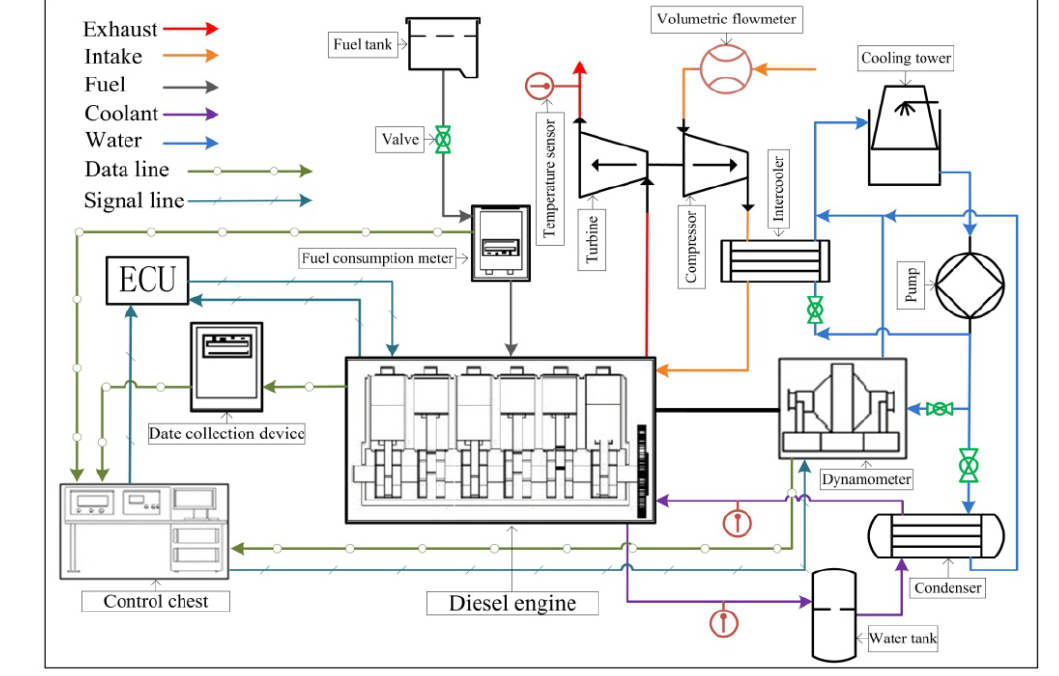
Figure 1. Schematic diagram of the diesel engine experimental system.